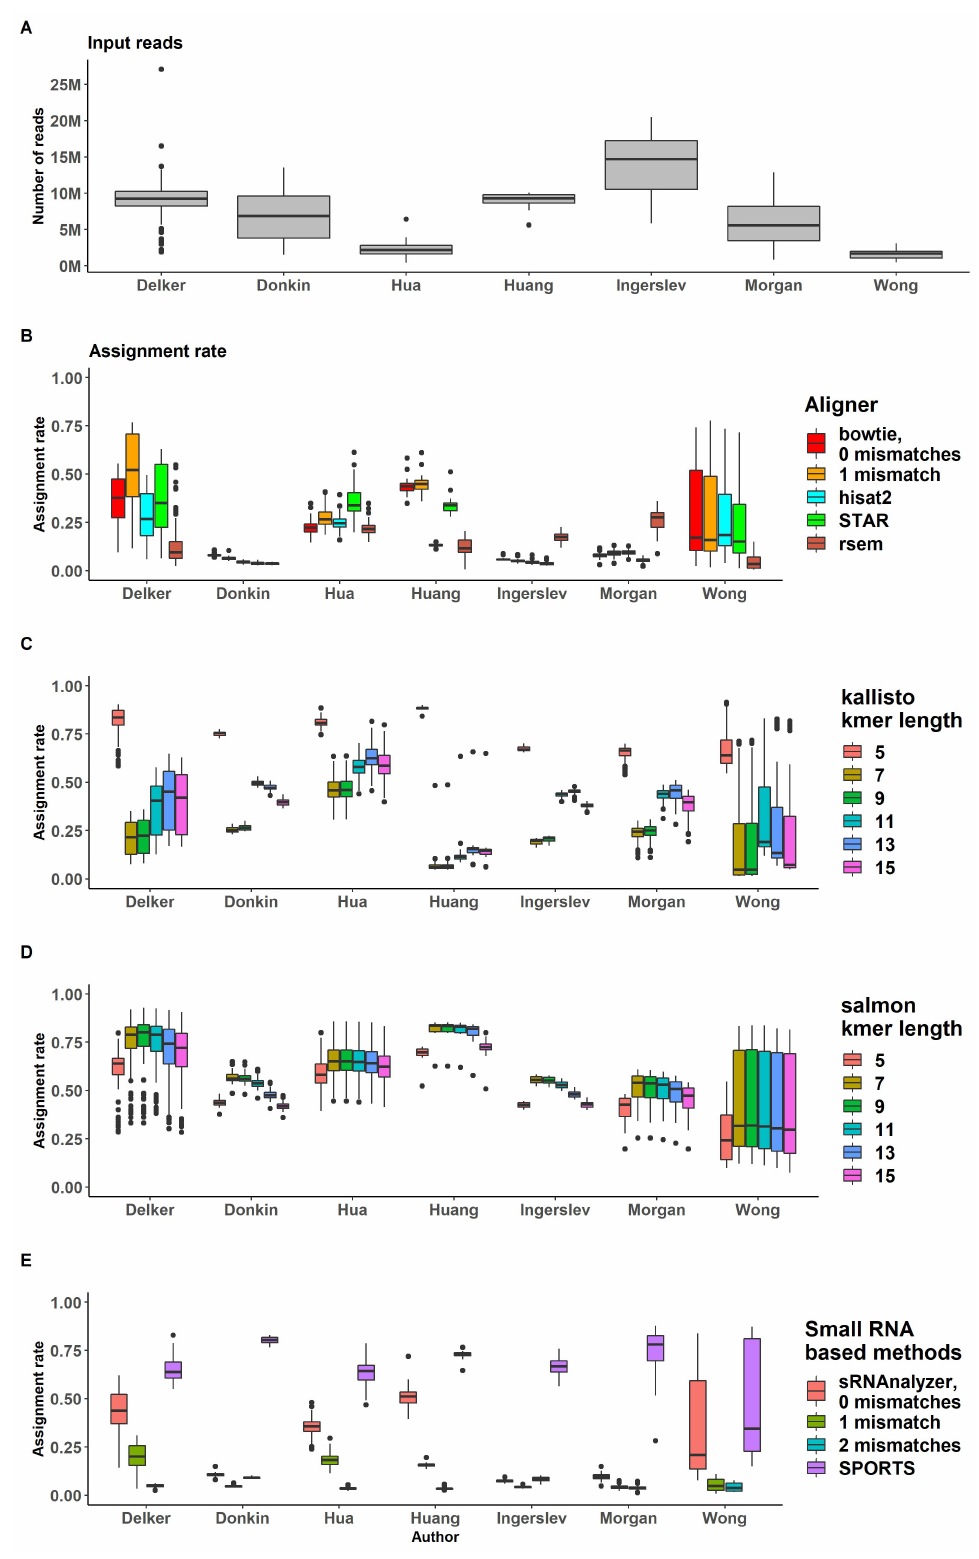
Figure 4. ( A ) Number of reads after trimming procedure across all datasets [58–64]. Percent of reads processed by ( B ) alignment-based pipelines; by ( C ) kallisto; by ( D ) salmon; by ( E ) small RNA based